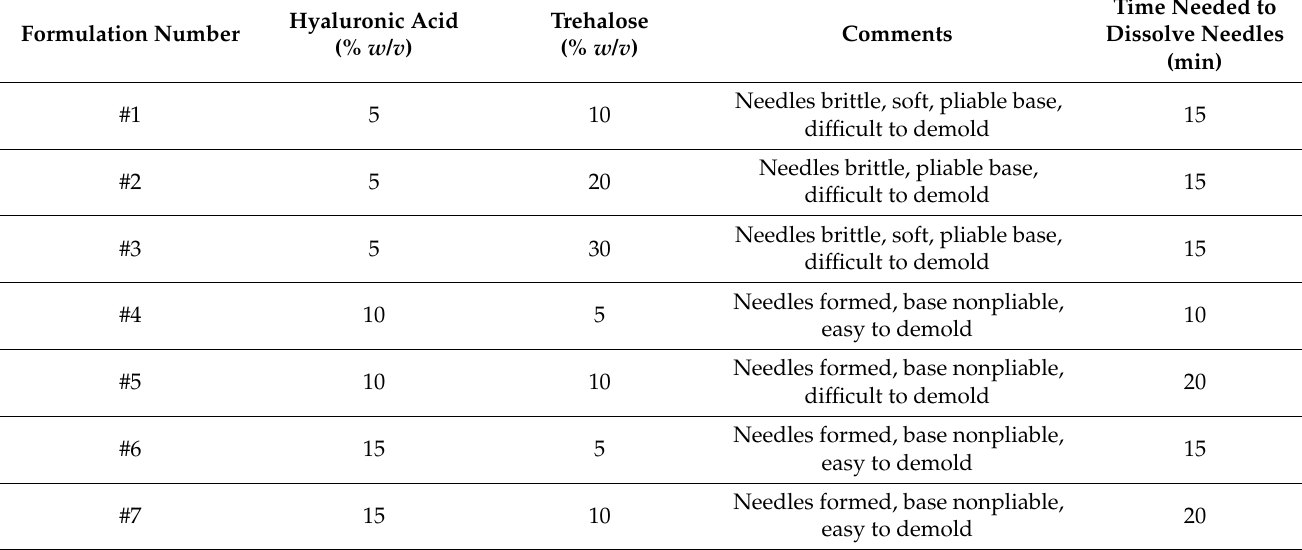
Table 1. Formulation optimization of the dissolving